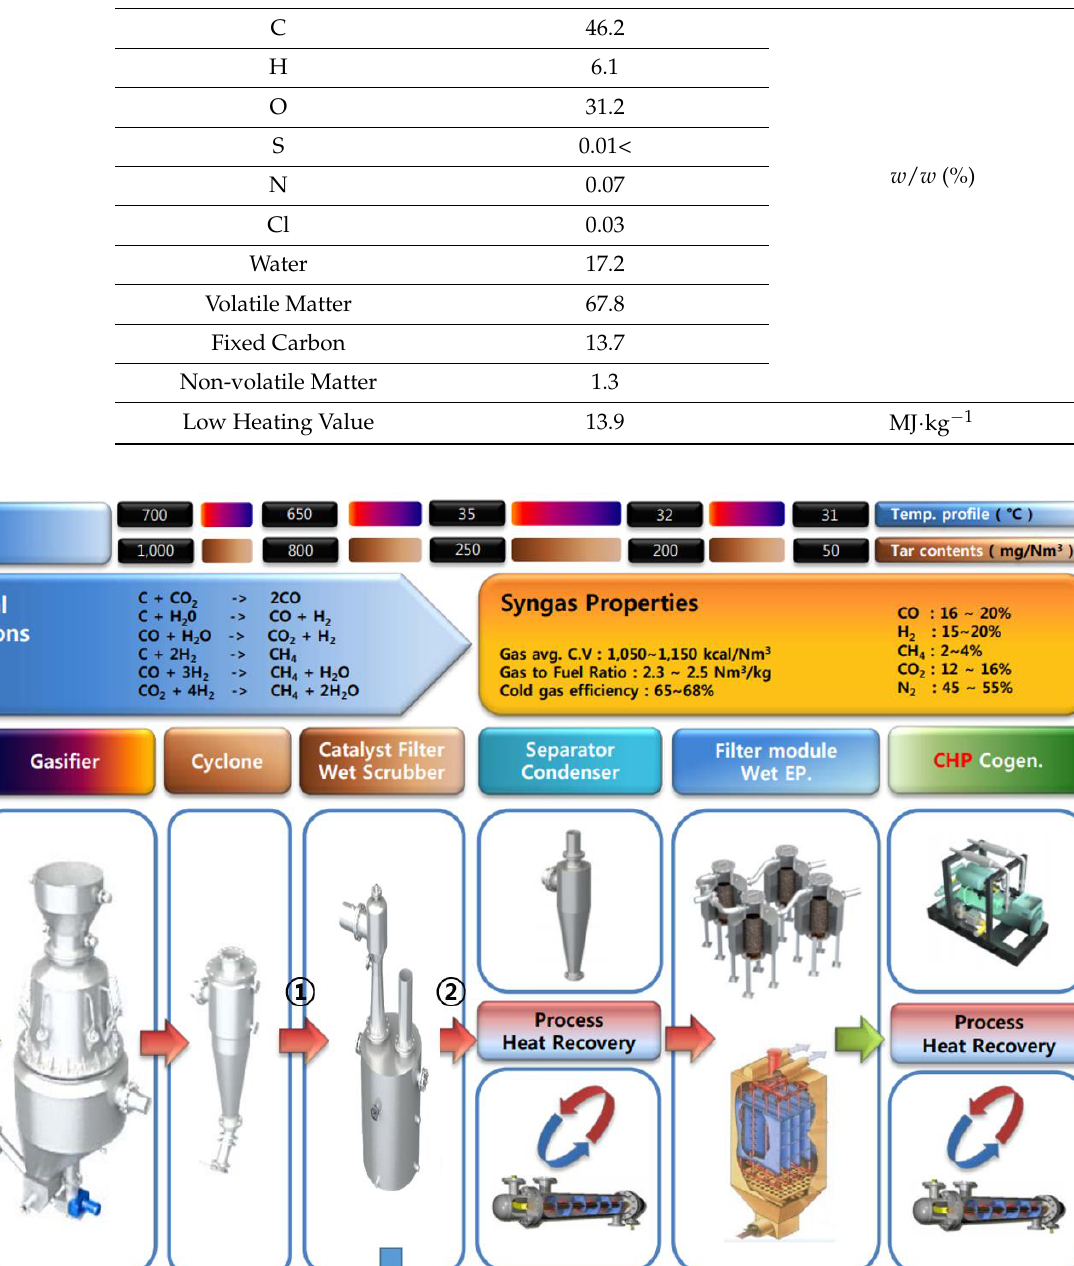
Figure 8. Schematic diagram of bench scale syngas refining reactor. 1st column: water scrubber with water spray volume 5 L∙min −1 , diameter 280 mm, height 500 mm, filled with ceramic ring filter (height 300 mm), spray water temperature below 20 ℃ , 2nd column: reactor filled with prepared clinoptilolite, diameter 260 mm and height 500 m, 3rd column: reactor filled